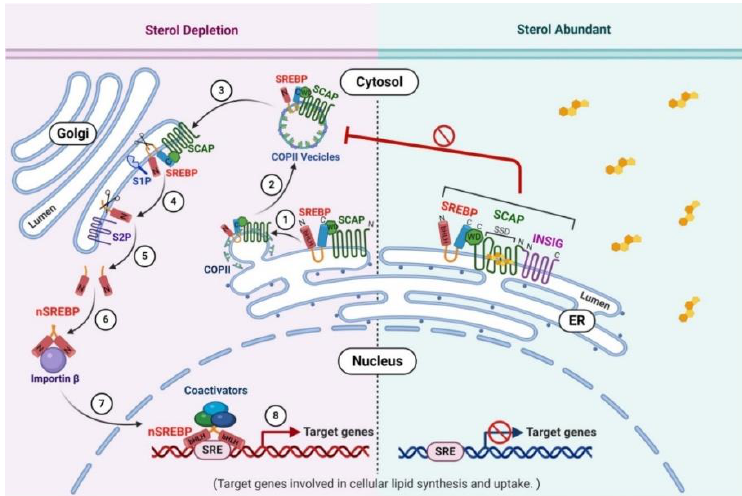
Figure 3. Schematic illustration of sterol-regulated proteolytic activation of SREBPs. Right : Under conditions when intracellular sterol levels are elevated, it directly binds to the sterol-sensing domain (SSD) of SCAP, causing a conformational change in SCAP which triggers SCAP bind to another ER-resident membrane protein INSIG. The association of SREBP-SCAP-INSIG ternary complex results in retention of SREBP precursors in the ER and prevents the movement of SREBP-SCAP complex to the Golgi, thus inhibiting the proteolytic maturation of SREBP in the Golgi. Left : In the absence of sterol, INSIG is no longer associated with SREBP-SCAP in the ER (1), and SREBP-SCAP complex is loaded into COPII vesicles which bud out of the ER membrane (2) and subsequently fuse with the Golgi apparatus (3). In the Golgi, Site-1 Protease (S1P) carries out the first proteolytic cleavage (scissor) in the intra-luminal loop of SREBPs between the two membrane-spanning sequences (4). Once the two halves of the SREBP are separated, a Golgi intramembrane metalloprotease Site-2 Protease (S2P) accomplishes the second cleavage (scissor) at a site located within the membrane-spanning region in the NH2-terminal domain of SREBP, releasing the bHLH-Zip domain which represents the mature SREBP (nSREBP) (5). Two nSREBP fragments dimerize and interact with importin β (6), and translocate to the nucleus (7) where nSREBP bind to sterol regulatory element (SRE) sequences as a dimer to gene promoter/enhancer regions and activate target genes that control synthesis and uptake of cholesterol, fatty acids, triglycerides, and phospholipids (8). SREBP, sterol regulatory element-binding protein; SCAP, SREBP cleavage-activating protein; SSD, sterol-sensing domains; WD: Tryptophan-Aspartate repeat motif; INSIG, insulin-induced gene; COPII, coat protein II; ER, endoplasmic reticulum; S1P, site-1 protease; S2P, site-2 protease; SRE, sterol regulatory element.